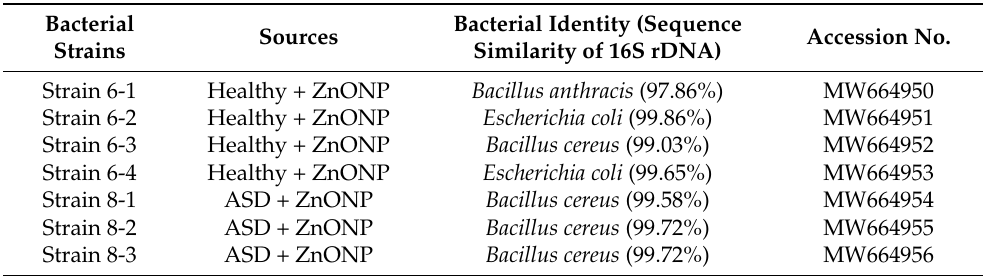
Table 1. Similarity analysis of 16S rDNA sequence in the representative bacterial strains from the mixed fecal samples of the ASD and healthy children. Bacterial Identity (Sequence Bacterial Accession No. Sources Similarity of 16S rDNA) Strains Strain 6-1 Bacillus anthracis